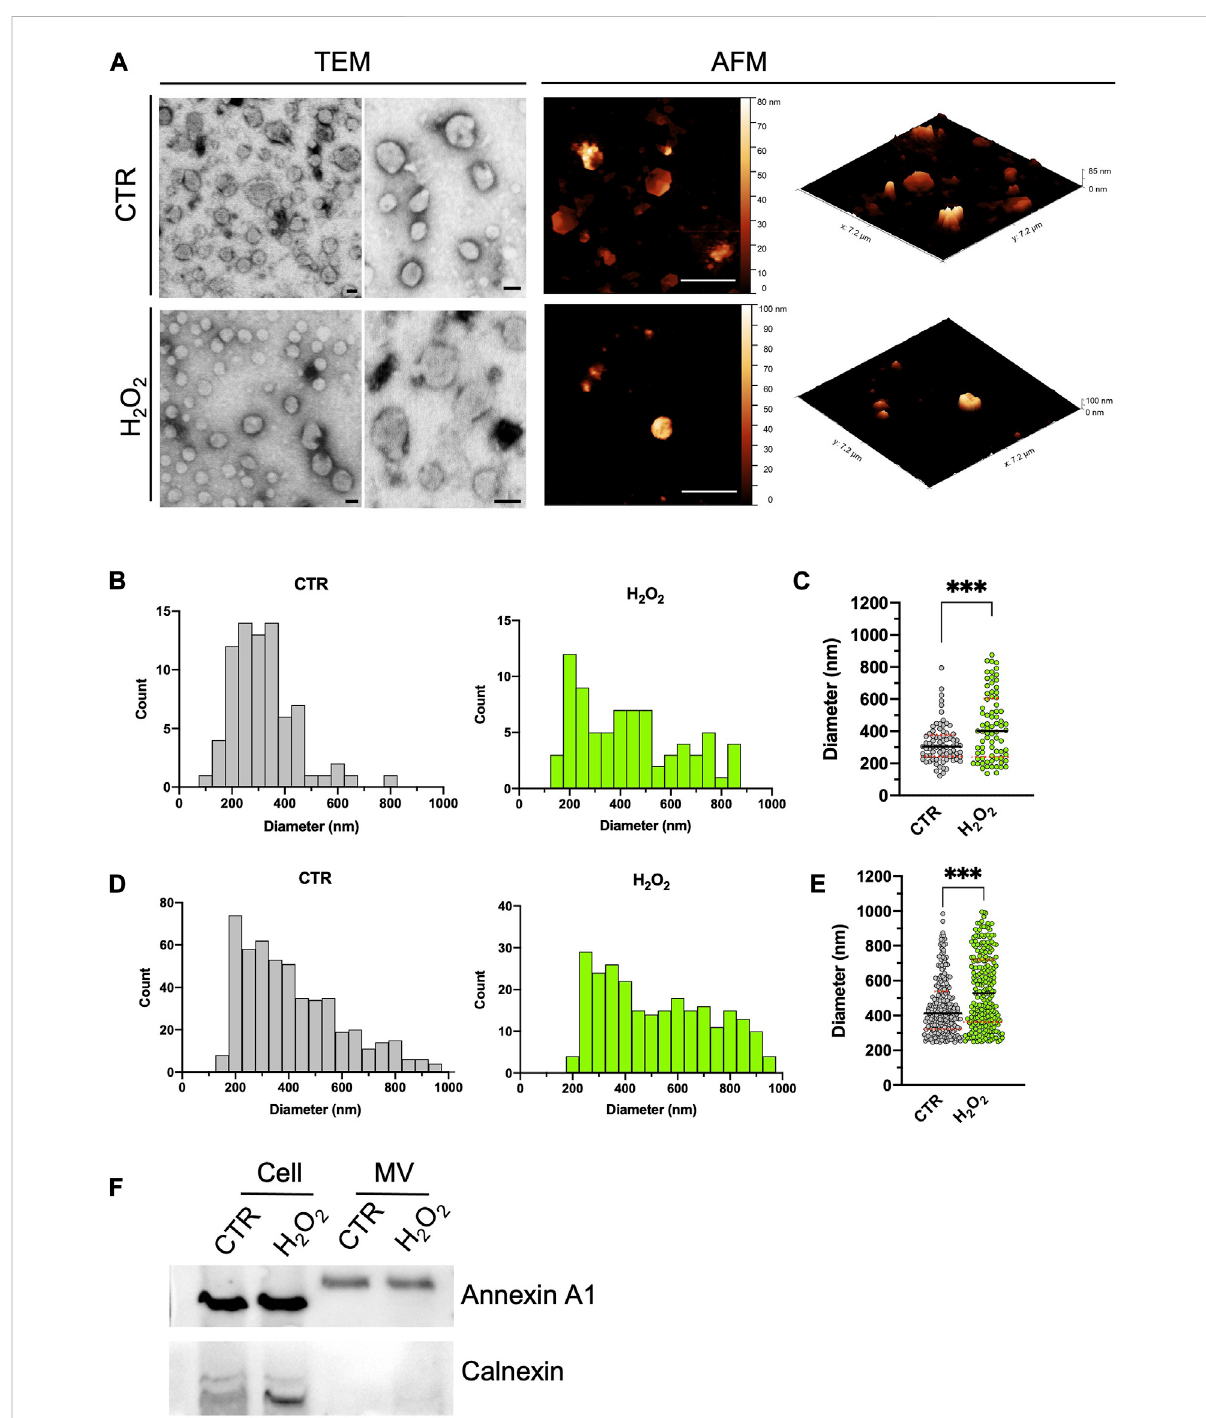
FIGURE 2 Comparison between STEM and AFM imaging on isolated vesicles. (A) : two typical STEM (left, scale bar 100 nm) and AFM (right, scale bar 2 µm) imagesacquiredonisolatedbuddingvesiclesderivedfromcontrol( fi rstrow)andH2O2treatedcells(secondrow).ForeachAFMimageisalsoshown in its native 3D-view to better highlight the shape of the vesicles. (B) to (E) : statistical analysis of the size distribution of the vesicles as measured with the STEM (B,C) and AFM (D,E) performed of vesicles derived from control (grey values) and H2O2 treated cells (green values). A direct comparison between the two size distributions is shown for STEM [ (C) , median diameter of 305 ± 14 nm for the vesicles derived from control cells and 401 ± 24 nm for the ones derived from H2O2-treated cells] and AFM [ (E) , median diameter of 412 ± 10 nm for the vesicles derived from control cellsand528±13 nmfortheonesderivedfromH2O2-treatedcells]data.Forbothtechniquestheobtaineddistributionsarestatisticallydifferent( p < 0.05). (F) : SDS-PAGE gel electrophoresis showing the presence of Annexin A1 (microvesicles marker) and calnexin (endoplasmic reticulum